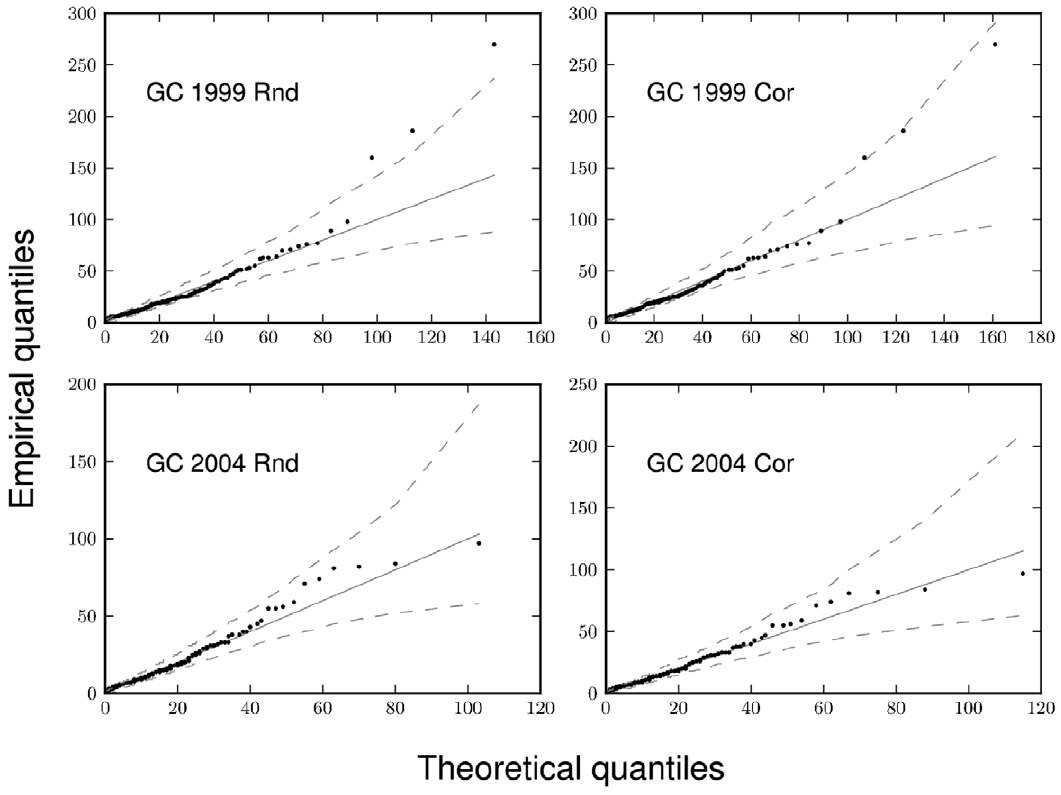
Figure 2. Bayesian fits of the model to the four GC grid datasets, as visualized with quantile-quantile plots. The ‘‘expected’’ distribution (solid lines) under the fitted accumulation model, as well as the 95% credible regions (dashed lines) around the predicted line, were generated via posterior predictive simulations.